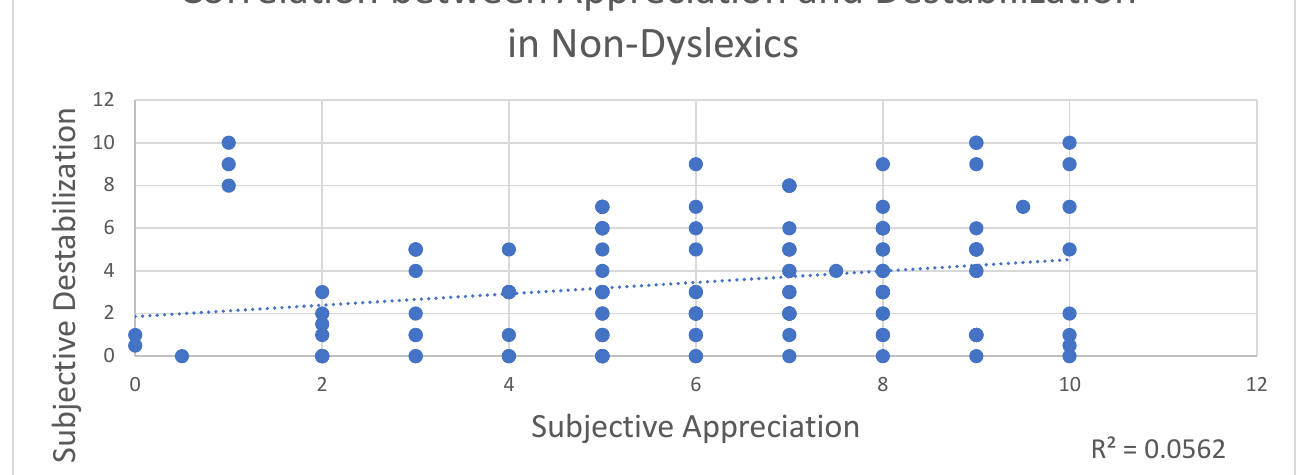
R² = 0.0562 R² = 0.0562